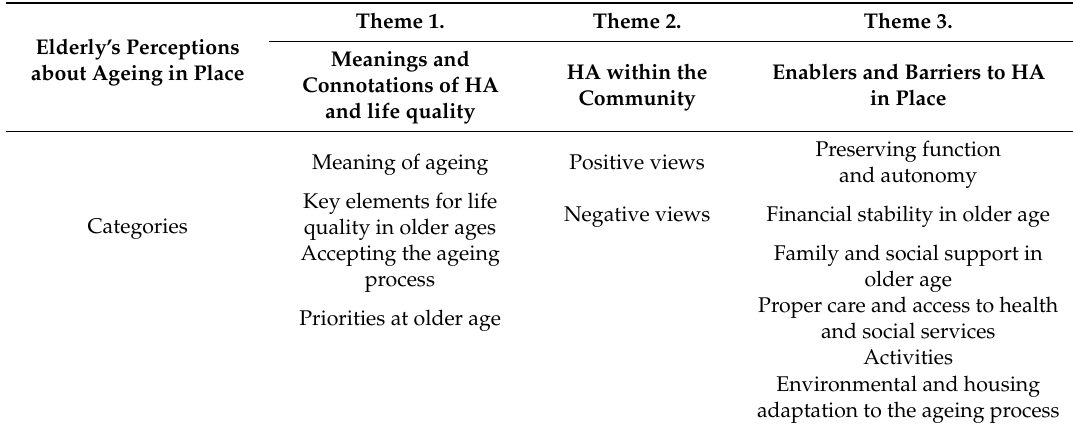
Table 1. Comprehensive list of themes and categories identified after thematic